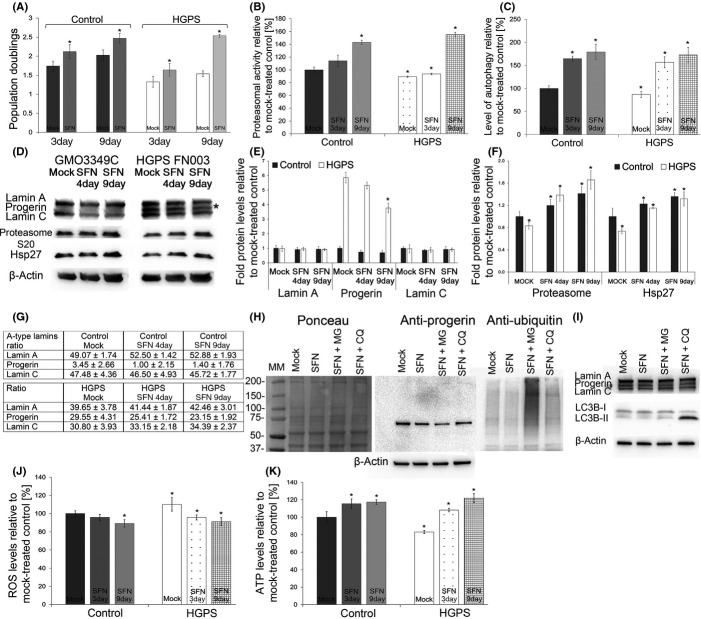
Sulforaphane (SFN) treatment rescues the Hutchinson–Gilford progeria syndrome (HGPS) cellular phenotypes. (A) Population doubling levels were calculated as described in the Materials and Methods for control and HGPS cells that were mock treated (vehicle DMSO) or treated daily with 1 μmSFN for a period of 3 or 9 days. (B) Proteasome activity was determined by measuring chymotrypsin-like proteasome activity in four control and four HGPS fibroblast lines using Suc-LLVY-AMC as a substrate. The percentage of activity was calculated relative to the activity in mock-treated control cells. Data are expressed as the mean ± SD (*P < 0.05; n = 4). (C) The same cells and culture conditions as in (B) were used to determine autophagy activity by measuring monodansylcadaverine (MDC) levels using fluorescence photometry, as indicated in the Procedures. Data are presented as the mean ± SD (*P < 0.05; n = 4). (D) Representative Western blots for lamin A/C, proteasome subunit 20S C2, Hsp27, and β-actin in total cell extracts isolated from mock-treated control and HGPS cells and cells treated with 1 μmSFN daily for a period of 4 or 9 days. (E and F) Quantification of Westerns (D) for lamin A, lamin C, progerin, proteasome subunit 20S C2 and Hsp27 levels normalized to β-actin and presented as the fold change relative to the levels in mock-treated control cells (*P < 0.05; n = 5). (G) The proportions of lamin A, progerin, and lamin C were determined within each sample analyzed by Western blotting with anti-lamin A/C antibody in panel (D). (H) Representative Western blot of HGPS cell lysates from cultures that were mock treated or treated with SFN or SFN plus MG132 (MG) or with chloroquine (CQ). Left panel corresponds to Ponceau red staining of the blot probed sequentially with antibodies specific for progerin, ubiquitin, and β-actin (n = 3). (I) Representative Western blot of the same culture conditions as in (H) probed with antibodies specific for lamin A/C, LC3B-I and LC3B-II and β-actin (n = 3). (J) Intracellular reactive oxygen species (ROS) levels were determined by measuring oxidized dichlorofluorescein (DCF) levels using a 2′,7′-dichlorofluorescein diacetate (DCFDA) cellular ROS detection assay, as described in the Procedures. Data represent the mean ± SD (*P < 0.05; n = 3) compared with mock-treated counterparts. (K) Cellular ATP levels were measured using a CellTiter-Glo luminescence ATP assay, as described in the Procedures. Data represent the mean ± SD (*P < 0.05; n = 3) relative to mock-treated counterparts.